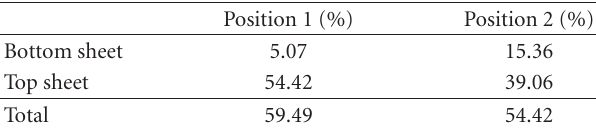
Table 5: Wetted area for bottom and top of the packing in % for silicon-oil